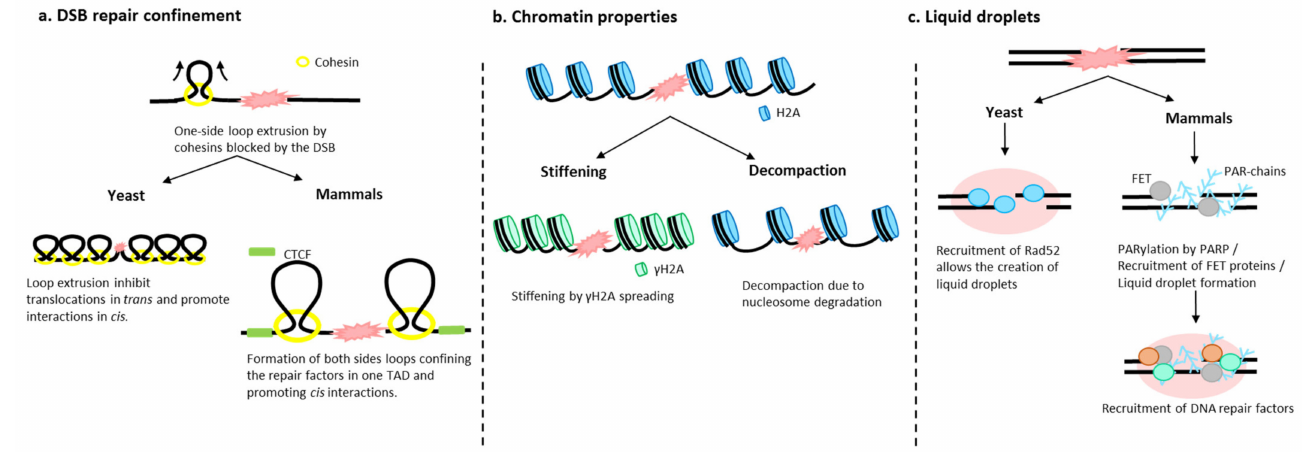
Figure 2. Factors that influence chromatin organization upon damage. ( a ) In yeast and mammals, upon damage, cohesins extrude DNA, creating a loop on one side of the damaged locus, as the DSB blocks cohesin progression. In yeast, cohesin loops cause chromosome individuation and limit the ability of DSB ends to explore their environment by decreasing trans contacts and favoring cis break repair [51]. In mammals, loop extrusion stops at DSB boundaries, confining repair proteins within a TAD [79]. ( b ) Chromatin undergoes intrinsic changes after a DSB such as stiffening by H2A(X) ( γ H2A(X)) phosphorylation, decompaction due to histone degradation, or condensation [85–90]. However, the intrinsic properties of chromatin after damage are not yet clear. ( c ) Upon damage, PARP-mediated PARylation is one of the first modifications observed in mammalian cells that allows the recruitment of FET proteins. The intrinsic highly structurally disordered domains of these proteins promote the formation of liquid droplets [91]. In yeast, the recruitment of repair proteins such as Rad52 are at the origin of liquid droplets, a likely means of isolating the DSB from the nuclear environment and concentrating some repair proteins